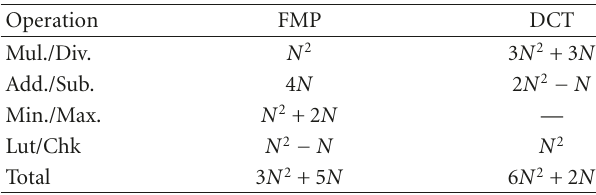
Table 8: Computation Complexity of FMP and